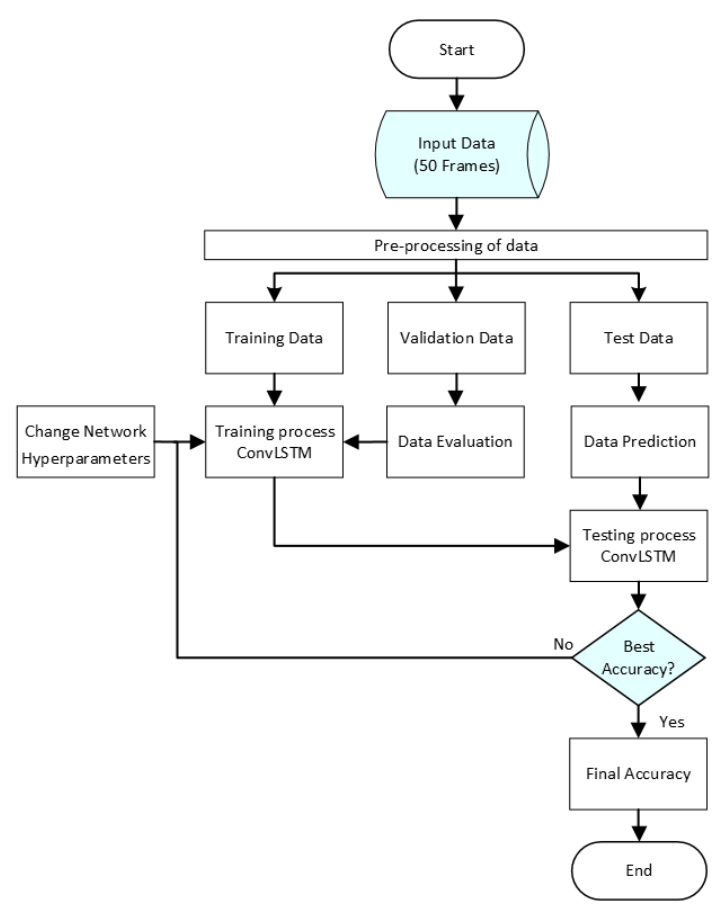
Figure 5. The flowchart of the proposed ConvLSTM. Table 1. The description of the layers of the proposed ConvLSTM.